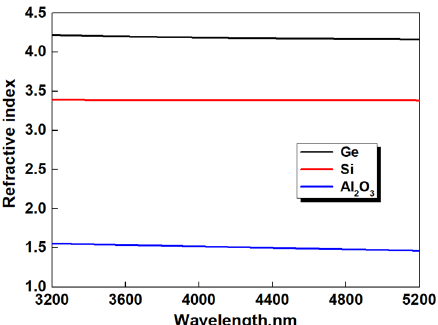
Figure 3. Refractive indices of Ge, Al 2 O 3 layers, and Si substrate. laser bands and high transmittance in the MIR region at AOI=45° was designed. The initial structure is a periodic structure composed of Ta 2 O 5 and SiO 2 as high- and low-refractive- index materials, respectively. This structure can be expressed as {[mH (2-m)L] N L}, and when m = 0.65, the theoretical spectrum can achieve high reflectance at 1064 and 532 nm